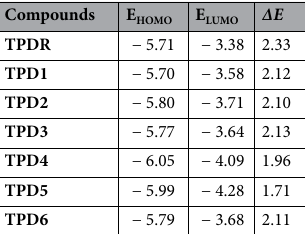
Table 1. The E HOMO , E LUMO and ΔE (E LUMO − E HOMO ) of entitled chromophores. Units in eV